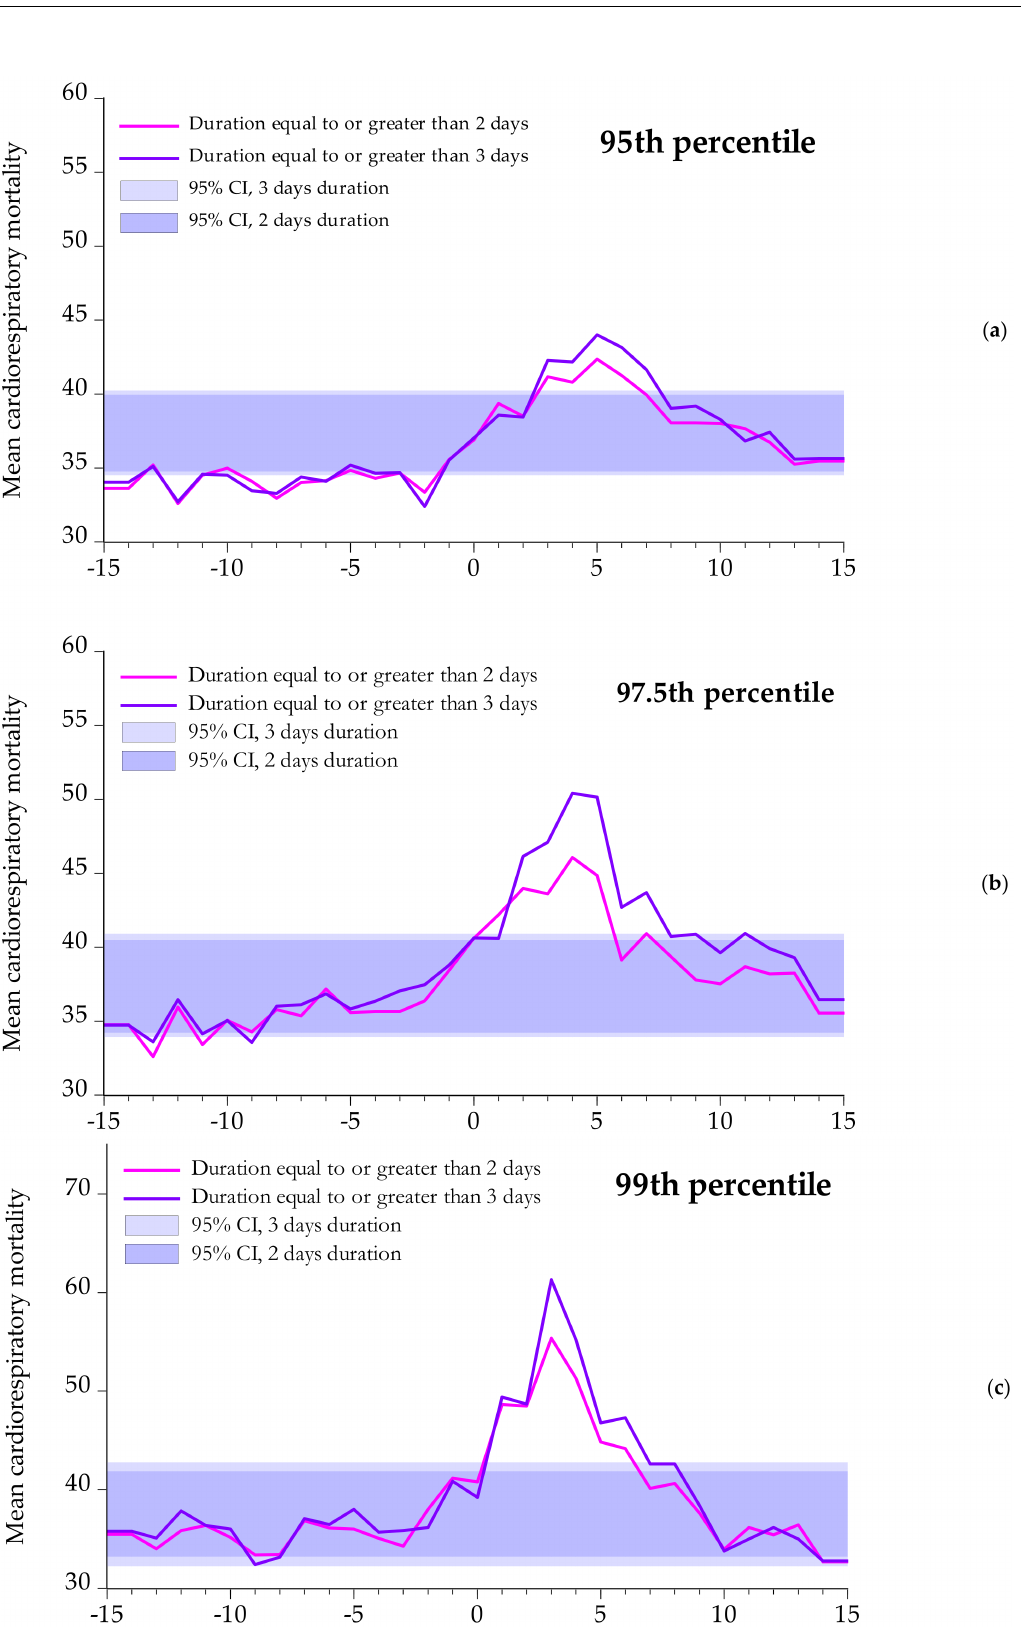
Figure 8. Superposed Epoch analysis for mortality due to cardiorespiratory diseases for duration of the heatwave event of at least 2 and 3 days: ( a ) 95th percentile; ( b ) 97.5th percentile; ( c ) 99th percentile. Notes: (i) The shaded area shows the 95% Confidence Interval (CI), (ii) the vertical axis measures the mean number of deaths due to cardiorespiratory mortality, (iii) the horizontal axis depicts the time 15 days before and 15 days after the heatwave event. Day 0 is the first day of the